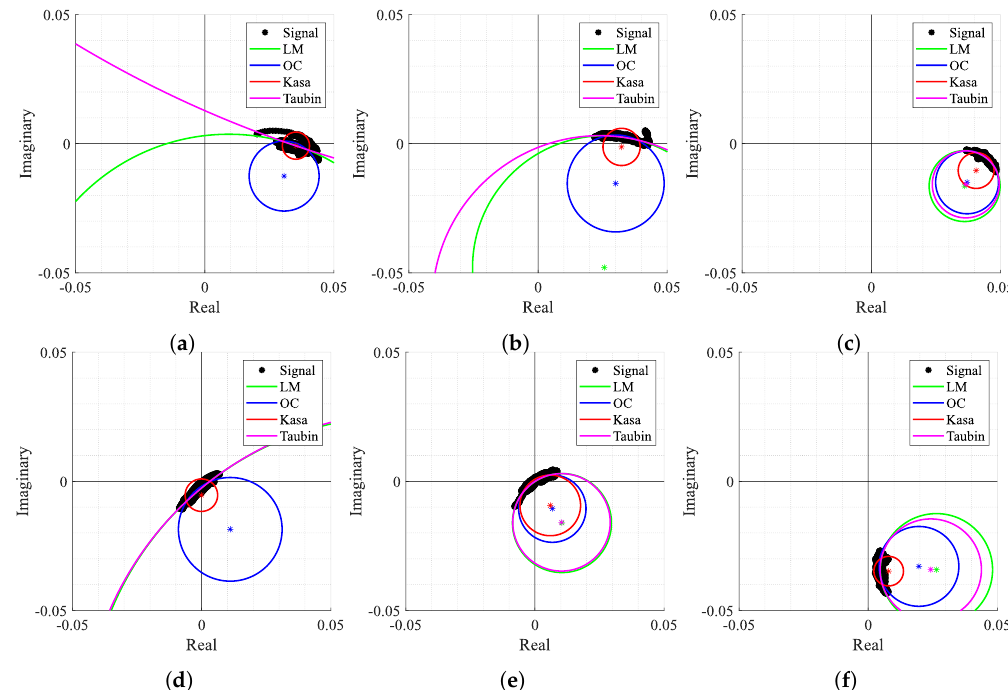
Figure 14. Circle fitting result over time for case 2: ( a ) Window nº 2, ( b ) Window nº 4, ( c ) Window nº 35, ( d ) Window nº 318,